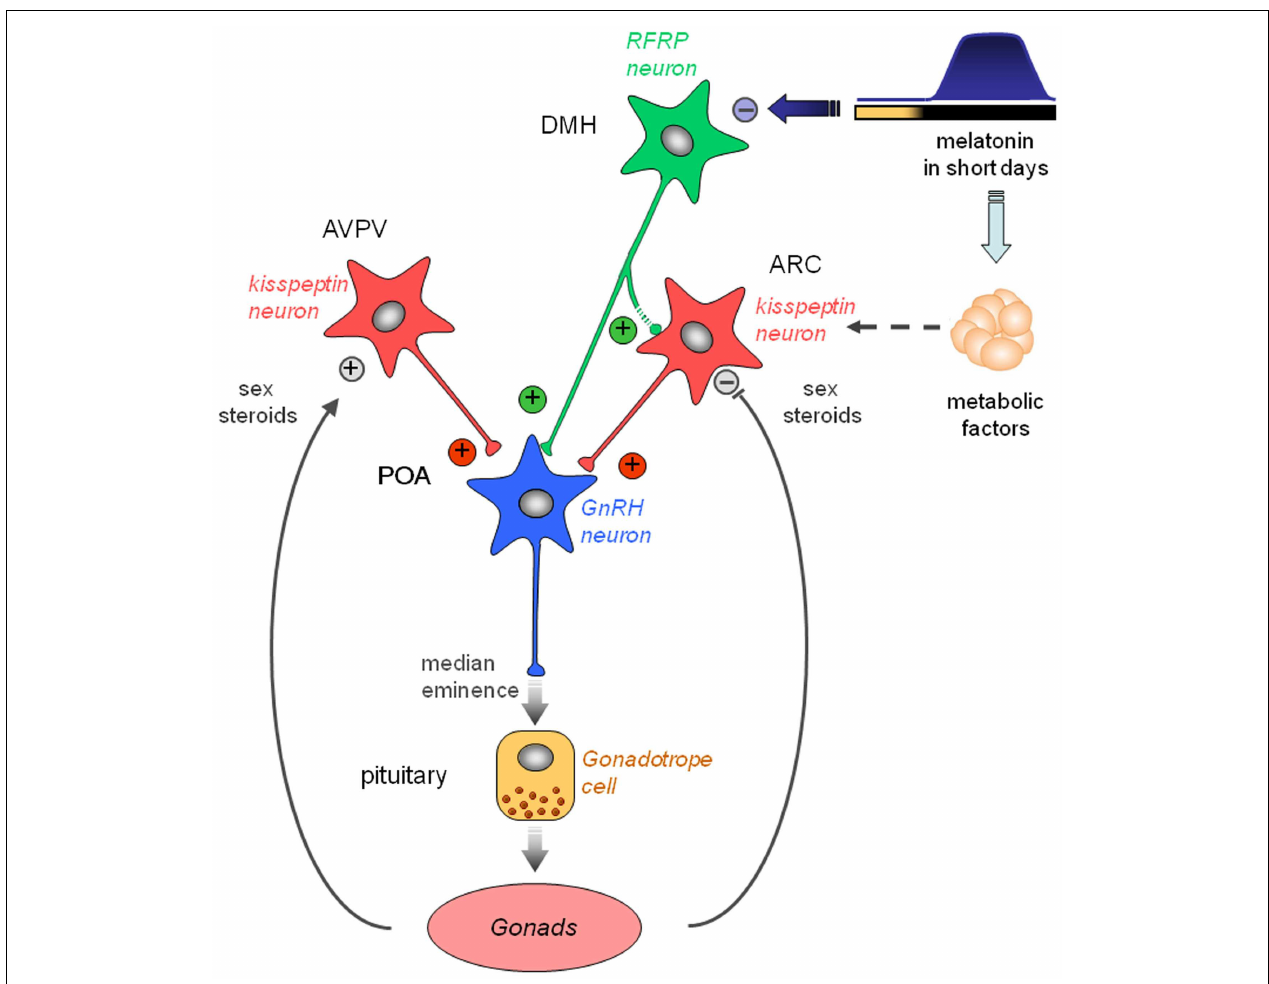
FIGURE 3 |Working model indicating how the photo-inhibitory melatonergic message in short day conditions is integrated in the hypothalamus to further regulate the gonadotropic axis of the male Syrian hamster. GnRH neurons located in the preoptic area (POA) project at the median eminence to release GnRH which stimulates the release of pituitary gonadotropins downstream. GnRH neuron activity is regulated upstream by two populations of peptidergic neurons, the kisspeptin neurons located in the anteroventral periventricular (AVPV) and arcuate (ARC) nuclei, and the RFRP neurons located in the dorsomedial hypothalamus (DMH). Kisspeptin expression is up-regulated in the AVPV and down-regulated in